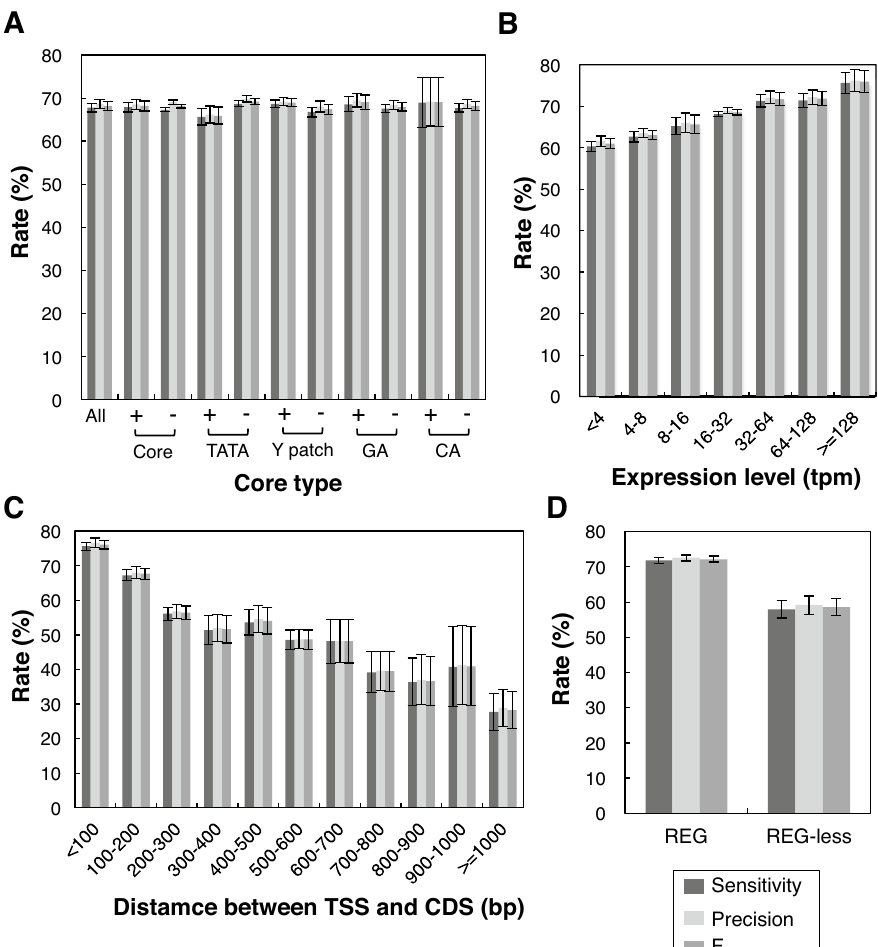
Figure 5. TSS prediction for various fractions of Genic Top promoters. Prediction was made for each chromosome using prepared PRI tables excluding the corresponding chromosome. The average and SD of data from five chromosomes is shown. Sensitivity, precision, and F are "true positives/ positives", "true positives/ predictions", and their harmonic mean, respectively. ( A ) Prediction scores according to the core types. Promoters containing an indicated core element are compared with the rest. The definition of core elements is as described by Yamamoto et al., 2007. Core means any of core elements, TATA, Y Patch, GA Element, or CA Element. ( B ) Prediction scores according to the expression levels. Expression data of TSS-Seq were used. ( C ) Prediction scores according to the distance between TSS and CDS. The TSSs were experimentally determined Top Genic TSSs. ( D ) Prediction scores according to the presence of REG. REG (Regulatory Element Group) is not a core element but a subset of cis -elements (Yamamoto et al.,